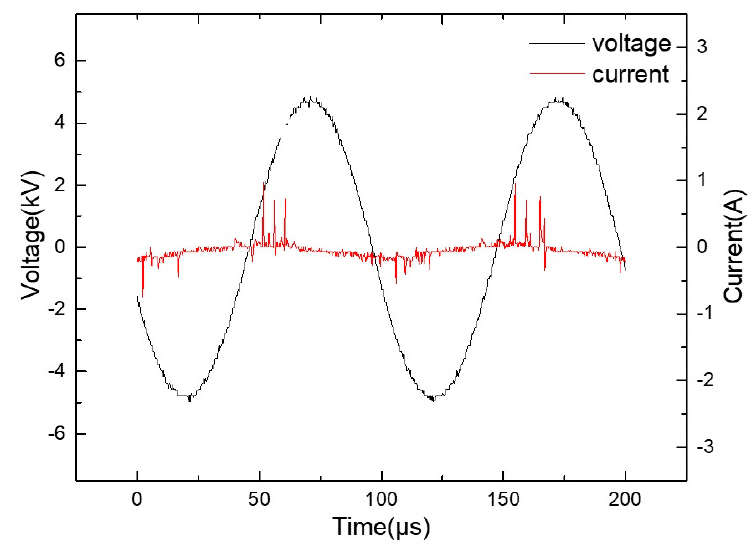
Figure 2. Voltage and current waveform of the device.